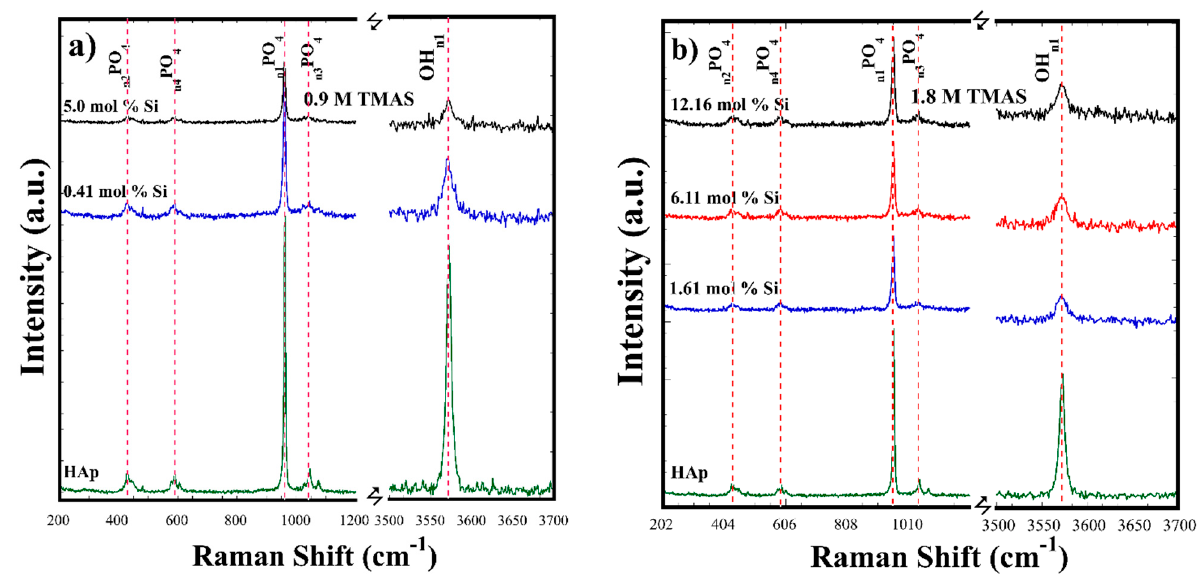
Figure 4. Raman spectra of the Si-HAp powders obtained by microwave assisted hydrothermal process at 150 °C for 1 h using different molar concentrations of the TMAS solutions: ( a ) 0.9 and ( b ) 1.8 M.